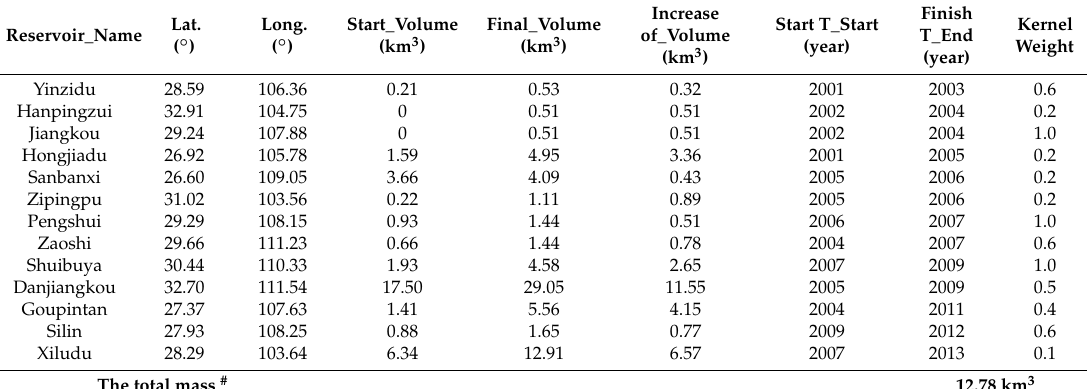
Table 2. Detailed information of the water storage for the analyzed reservoirs (except TGR) within the GRACE sensitivity